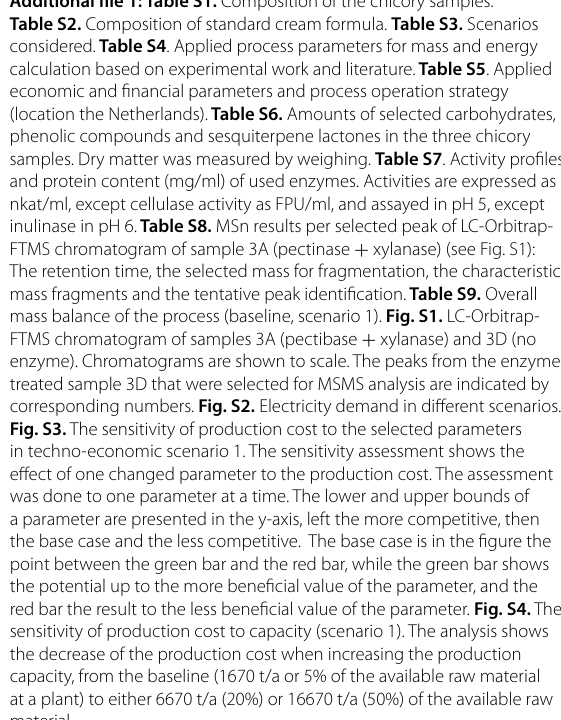
Fig. S3. The sensitivity of production cost to the selected parameters in techno‑economic scenario 1. The sensitivity assessment shows the effect of one changed parameter to the production cost. The assessment was done to one parameter at a time. The lower and upper bounds of a parameter are presented in the y‑axis, left the more competitive, then the base case and the less competitive. The base case is in the figure the point between the green bar and the red bar, while the green bar shows the potential up to the more beneficial value of the parameter, and the red bar the result to the less beneficial value of the parameter. Fig. S4. The sensitivity of production cost to capacity (scenario 1). The analysis shows the decrease of the production cost when increasing the production capacity, from the baseline (1670 t/a or 5% of the available raw material at a plant) to either 6670 t/a (20%) or 16670 t/a (50%) of the available raw